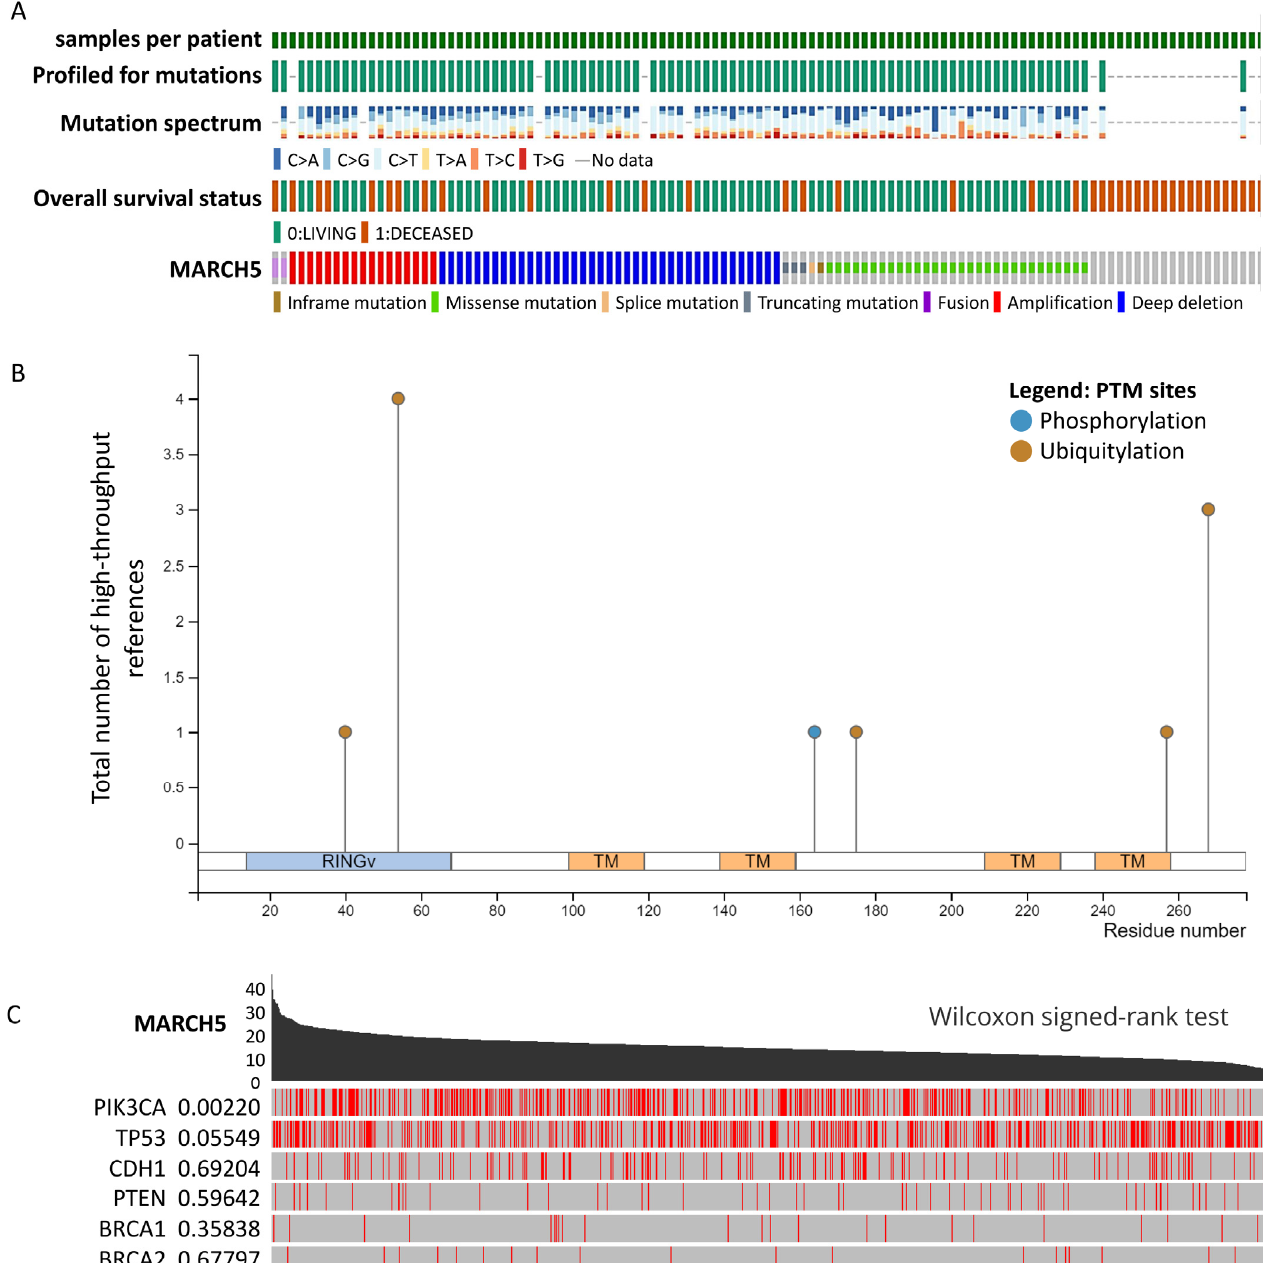
Figure 2. Mutation feature of MARCH5 in different cancers in TCGA. ( A ) A visual summary on a query of genetic alteration of MARCH5 in TCGA dataset. ( B ) The alteration frequency with mutation site is displayed. ( C ) The relationship between MARCH5 and six highly mutated genes in breast cancer. Red line represent mutation site.